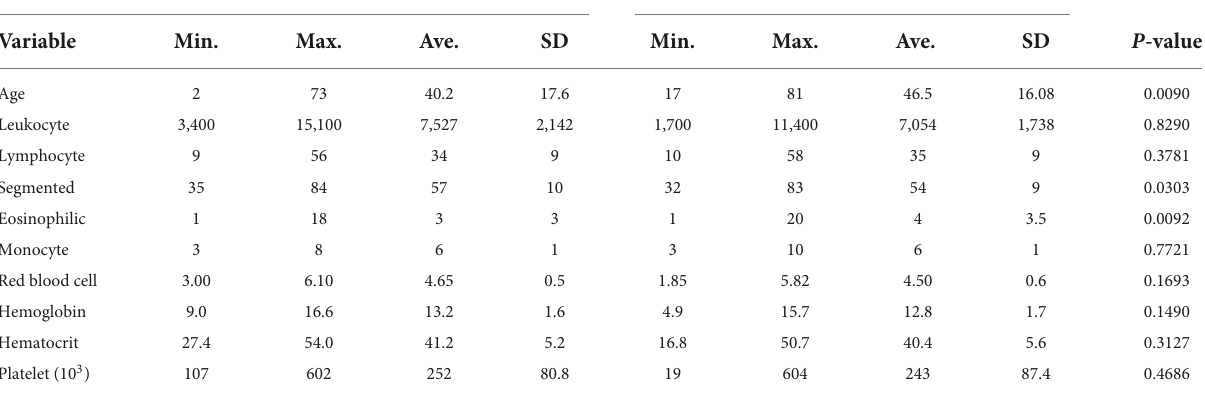
TABLE 2 Profile: Age and hematological parameter. Negative ( n = 115 ) Positive ( n = 87 ) Variable Min. Max.